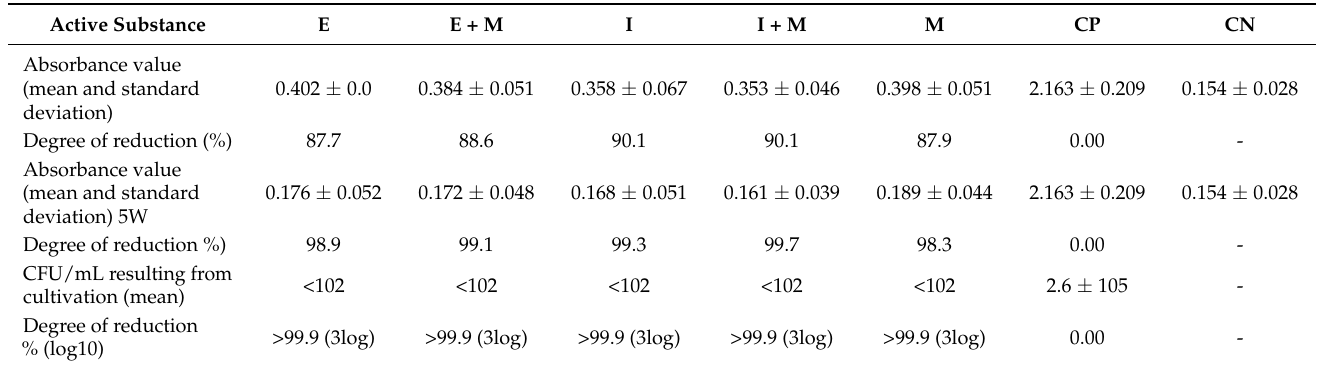
Table 3. Values of A. actinomycetemcomitans for the wells submitted to adjuvant laser therapy and photodynamic